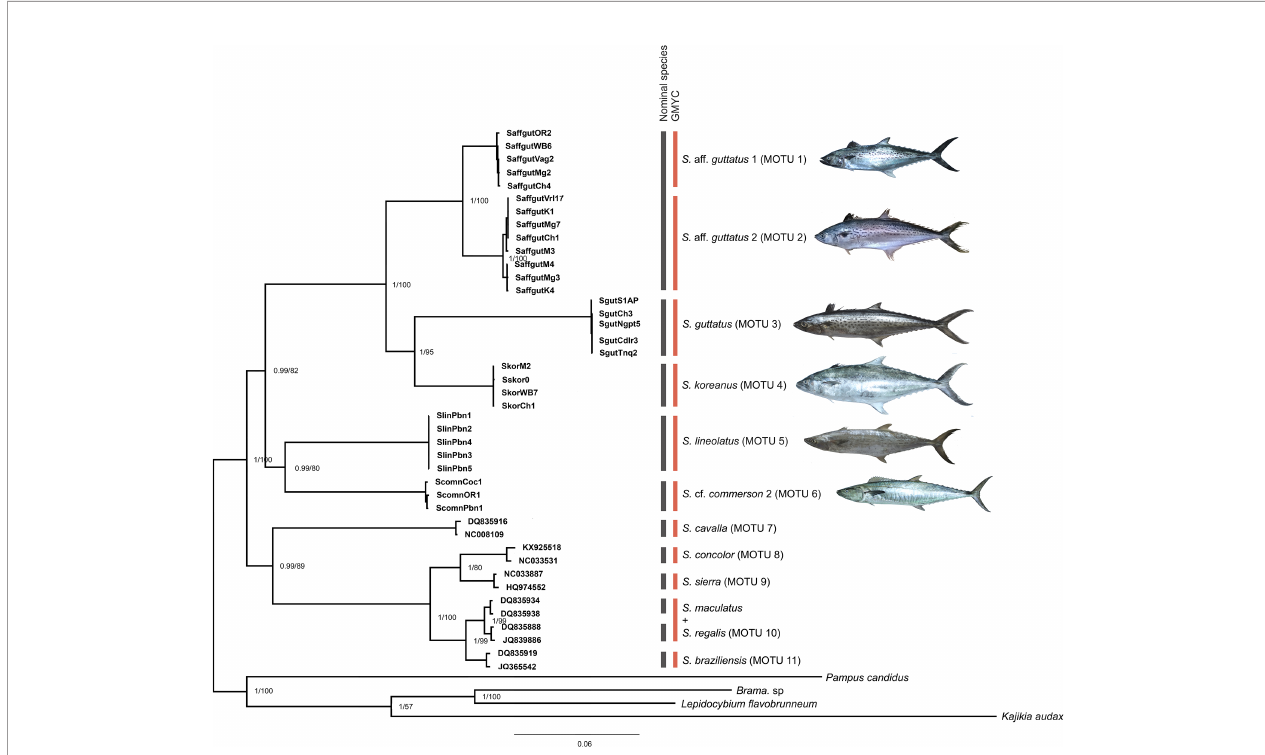
FIGURE 3 | Bayesian inference (BI) phylogram superimposed on maximum likelihood (ML) based on concatenated multilocus data is represented ( Table 4 ). The node numbers specify the posterior probability and bootstrap support values, respectively. The nominal species and the GMYC entities from the GMYC delineation method are indicated by different colors to the